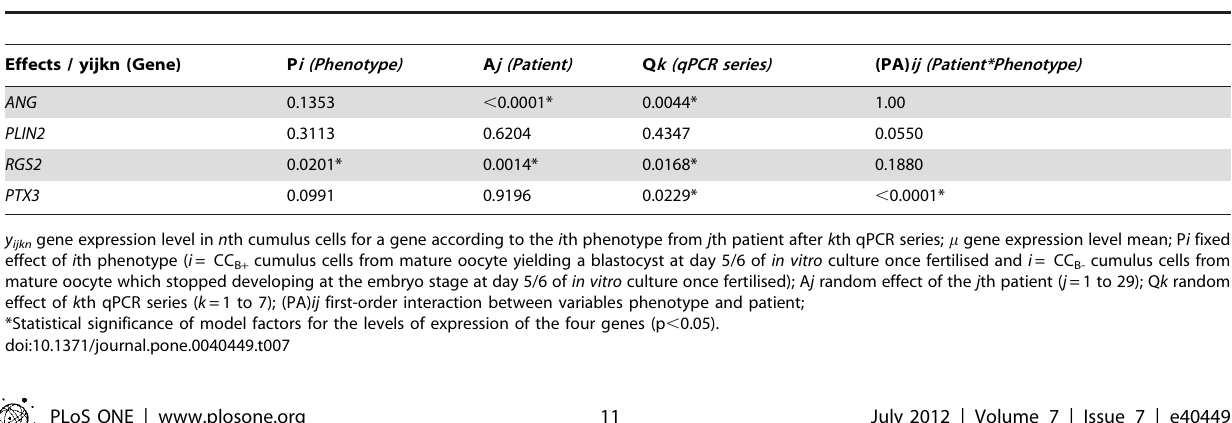
Table 7. Test of hypotheses for Mixed Model Analysis of Variance, impact of developmental competence, patient variability and experience ( i.e. qPCR series) on the level of gene